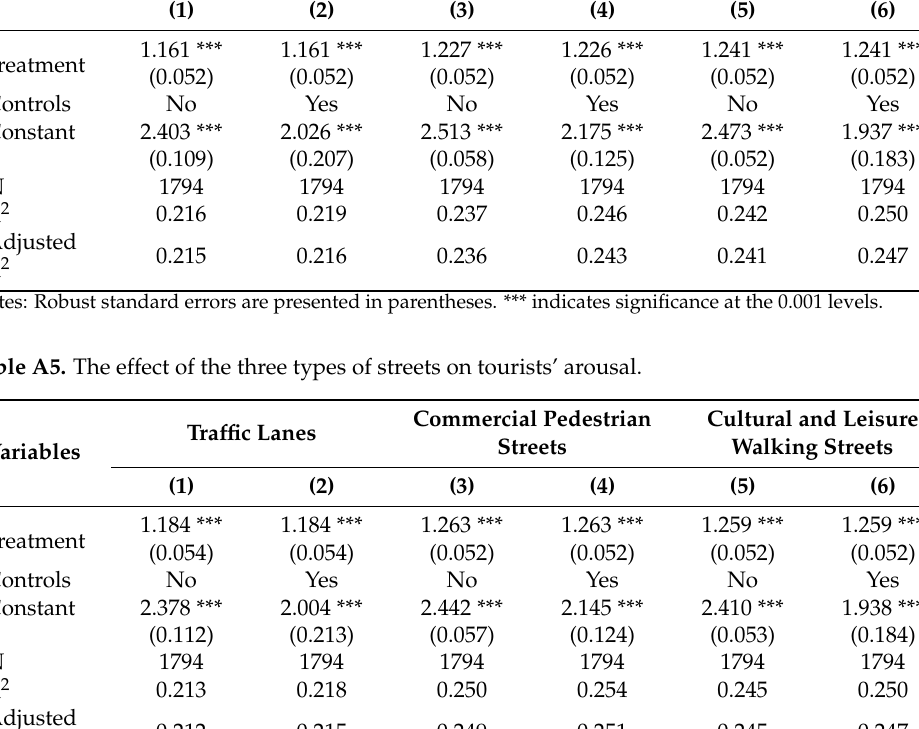
Treatment Controls